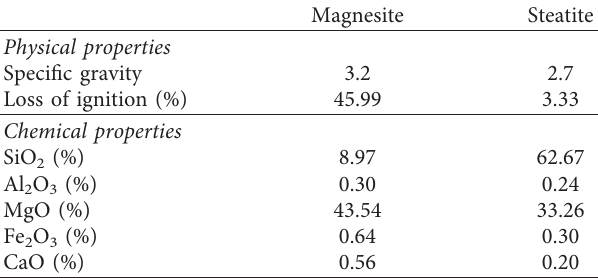
Table 1: Magnesite and steatite properties.